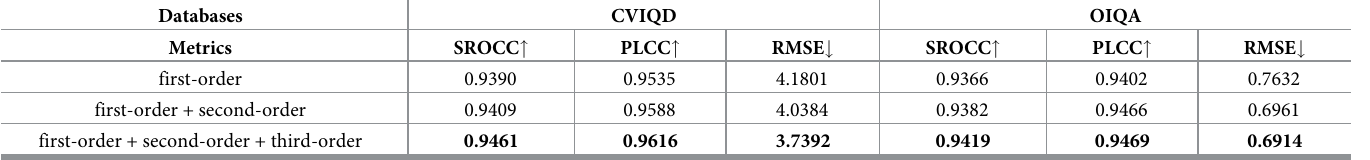
Table 4. Performance comparison of MRAPC method with different residual orders.